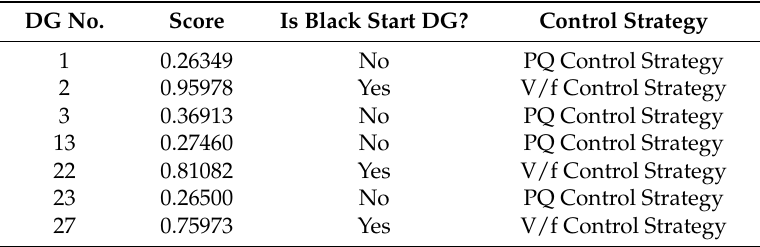
Table 3. The classification result of DGs. PQ: constant power; V/f: constant voltage and constant frequency. DG No. Score Is Black Start DG? Control Strategy